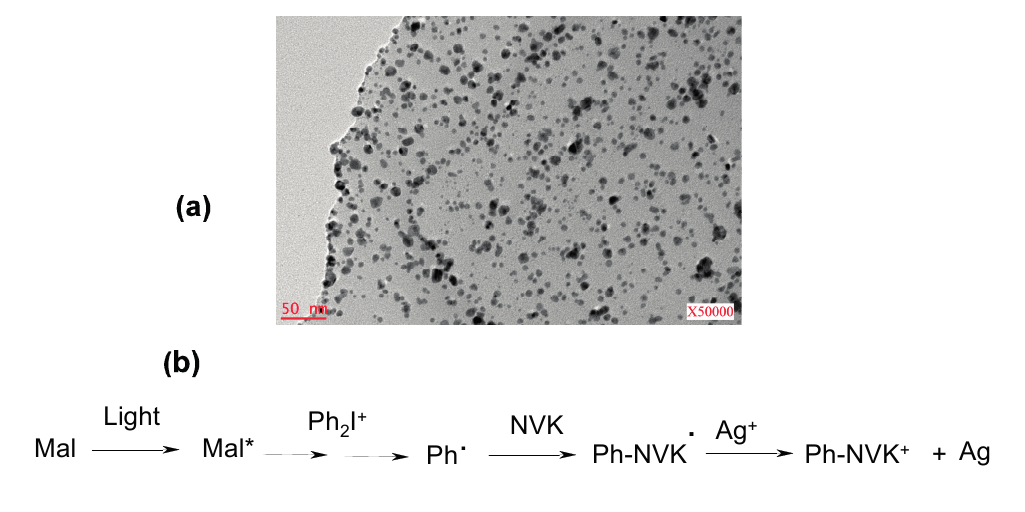
Figure 9. Push-pull malonate and malonitrile based dyes in photoinitiating systems for ROP and in-situ incorporation of silver nanoparticles in EPOX matrixes upon a Xe lamp exposure: ( a ) TEM micrograph and ( b ) chemical scheme for the formation of Ag(0)NP